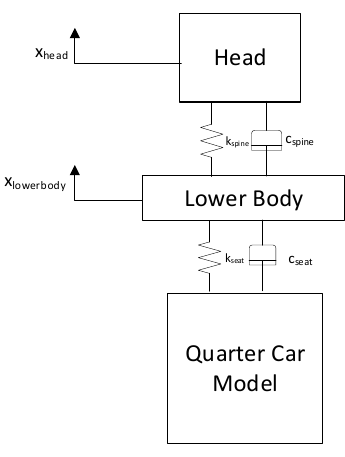
Figure 3. The four DOFs VSH model.